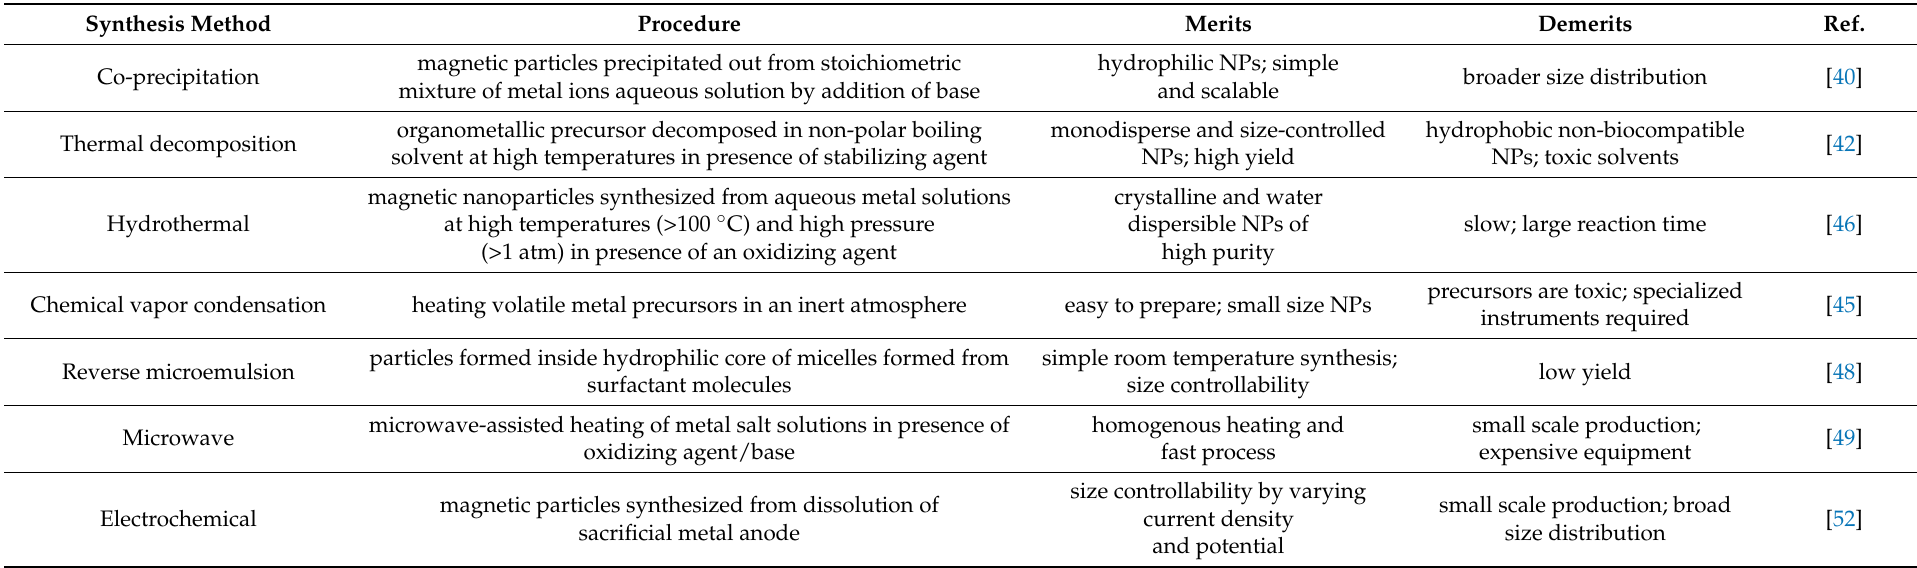
Table 1. Summary of methods employed for synthesis of magnetic